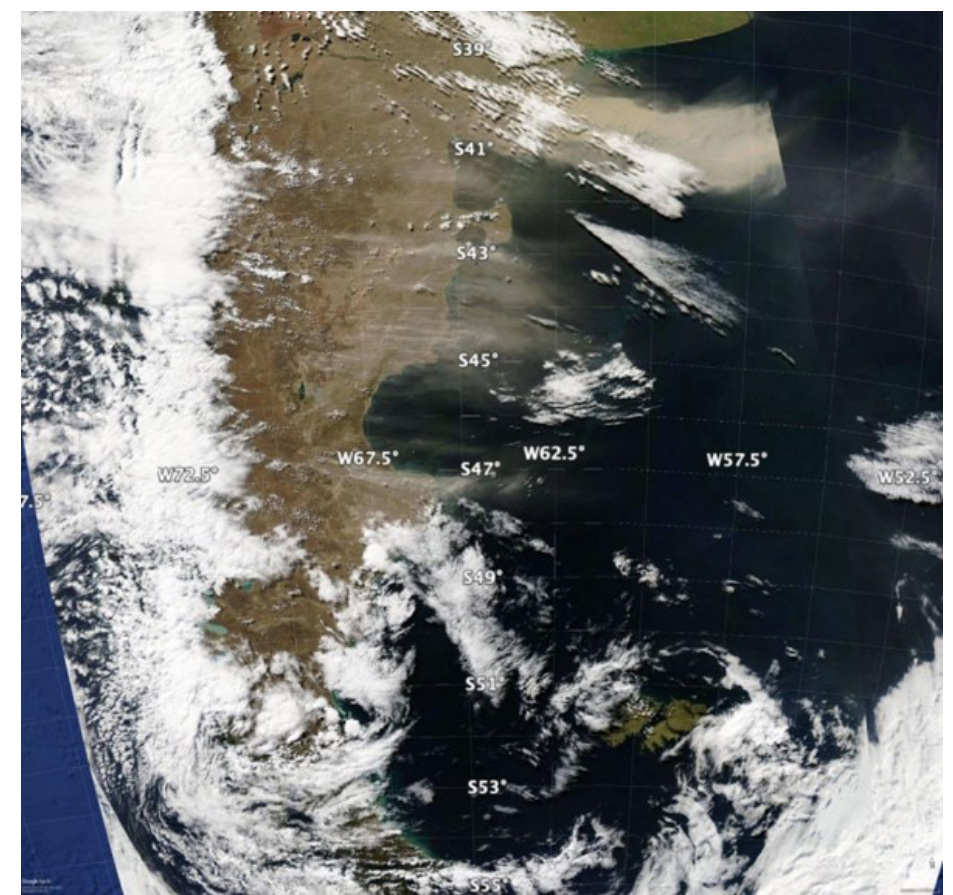
Figure 14. A dust event spanning the northern and central sections of the Patagonian Desert ( + 1000km) on 28 March 2009. Events this large occur about once every 1 to 3 years. This event is typical in that it was triggered by the passage of a powerful low-pressure center commonly found at these high latitudes. Also, this event is singular in that a large portion of it is cloudless, enabling a direct view from space (most dust activity in Patagonia occurs under cloudy conditions). The thick dust cloud in the upper right corner is from an area used for cattle farming, which was undergoing a drought, whereas the active sources further south can be considered more naturally occurring with less anthropogenic interference. Source: NASA’s Worldview interface image processed with Google